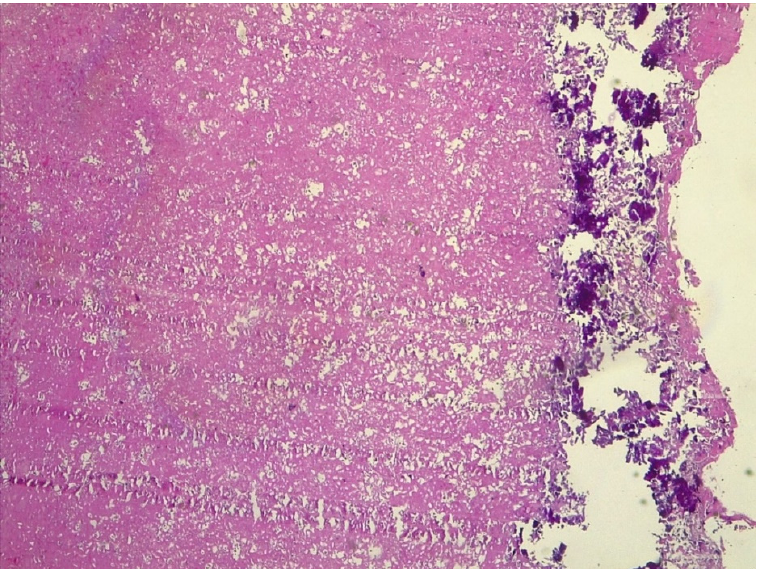
Figure 3. Histological specimen of the intracardiac mass revealing nonbacterial thrombotic endo- carditis (i.e., Libman–Sacks endocarditis).